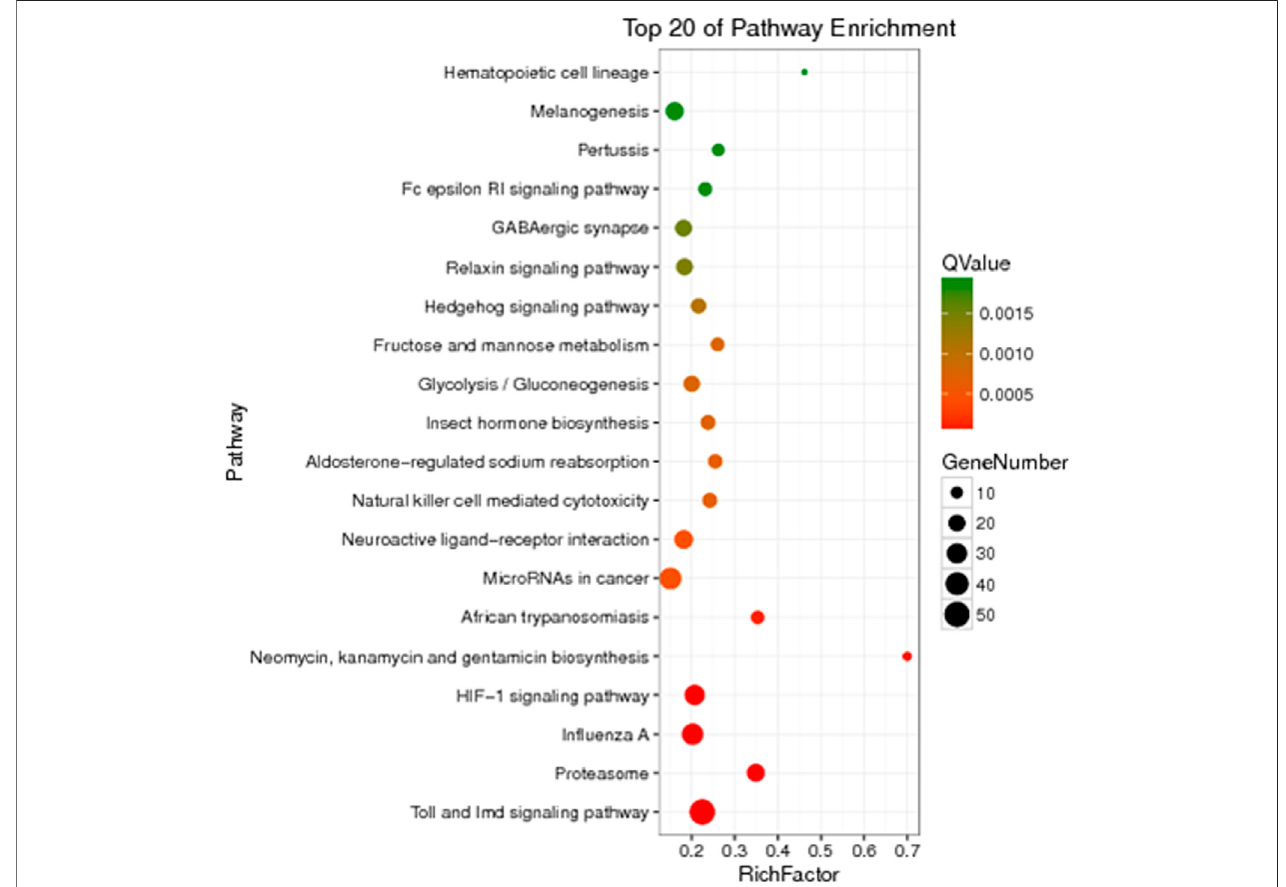
FIGURE 2 | KEGG enrichment analysis results of speci fi c genes of Zeugodacus cucurbitae (Coquillett).